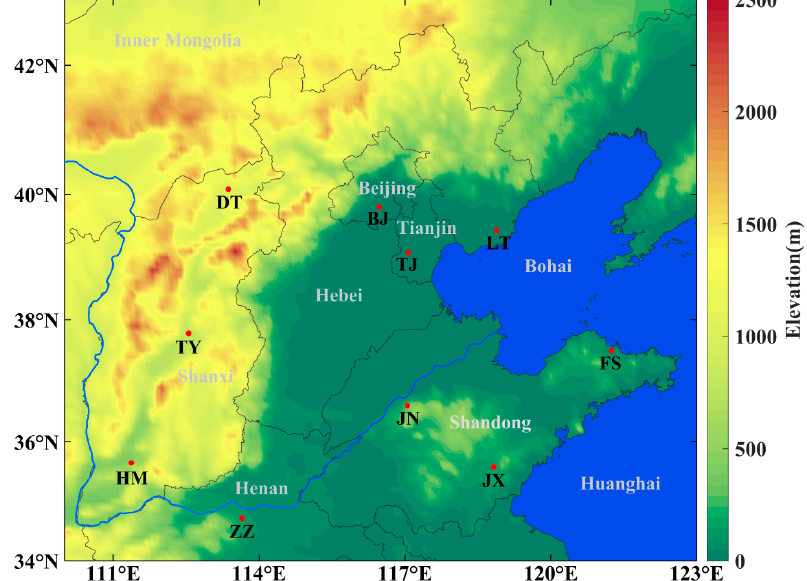
Figure 1. Elevation map and stations distribution in the study area. DT, TY, HM, BJ, TJ, LT, FS, JN, JX, and ZZ represent Datong, Taiyuan, Houma, Beijing, Tianjin, Laoting, Fushan, Jinan, JUxian, and Zhengzhou, respectively.